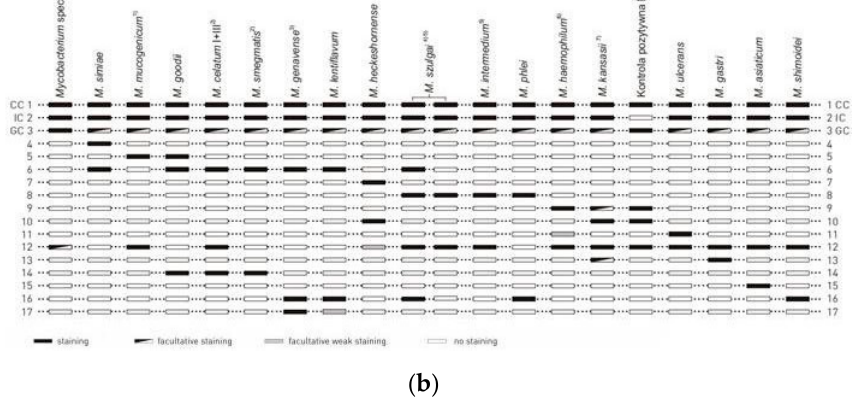
Figure 3. Mycobacterium szulgai identification test using the molecular method GenoType Mycobacterium CM/AM assay. Strip with results of M. szulgai identification from patient’s sample ( a ); interpretation according to the interpretation chart provided by manufacturer, HAIN Lifescience, Germany ( b ).